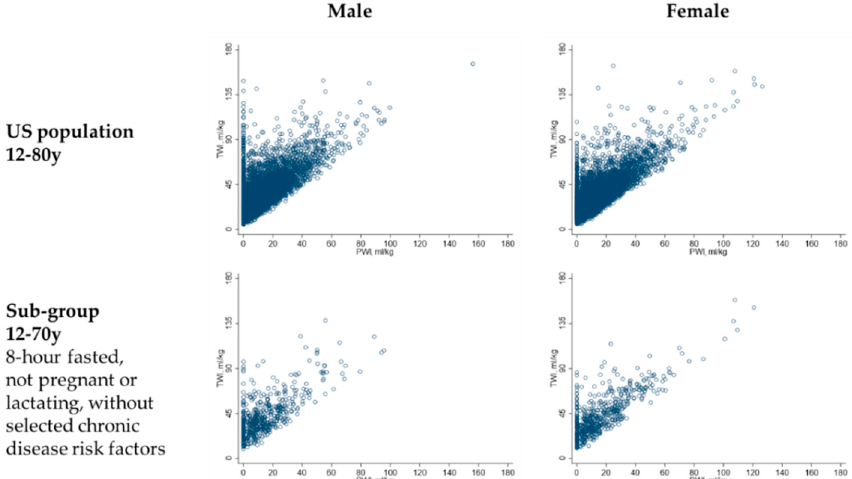
Figure 2. Total water intake (TWI) and plain water intake (PWI) of males and females in the study population. The figure illustrates the correlation between total water intake and plain water intake. Each dot represents the TWI and PWI of one NHANES 2009–2012 participant.